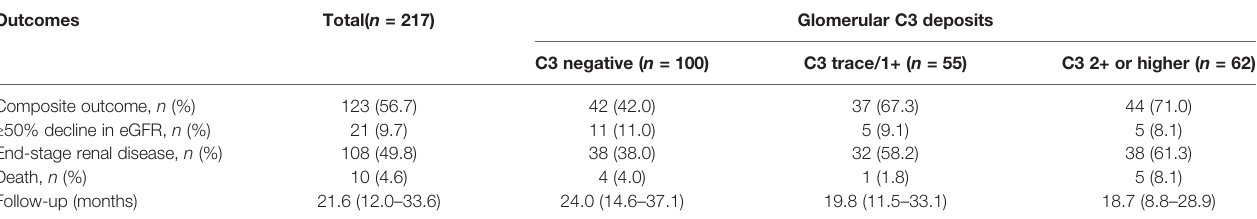
eGFR, estimated glomerular fi ltration